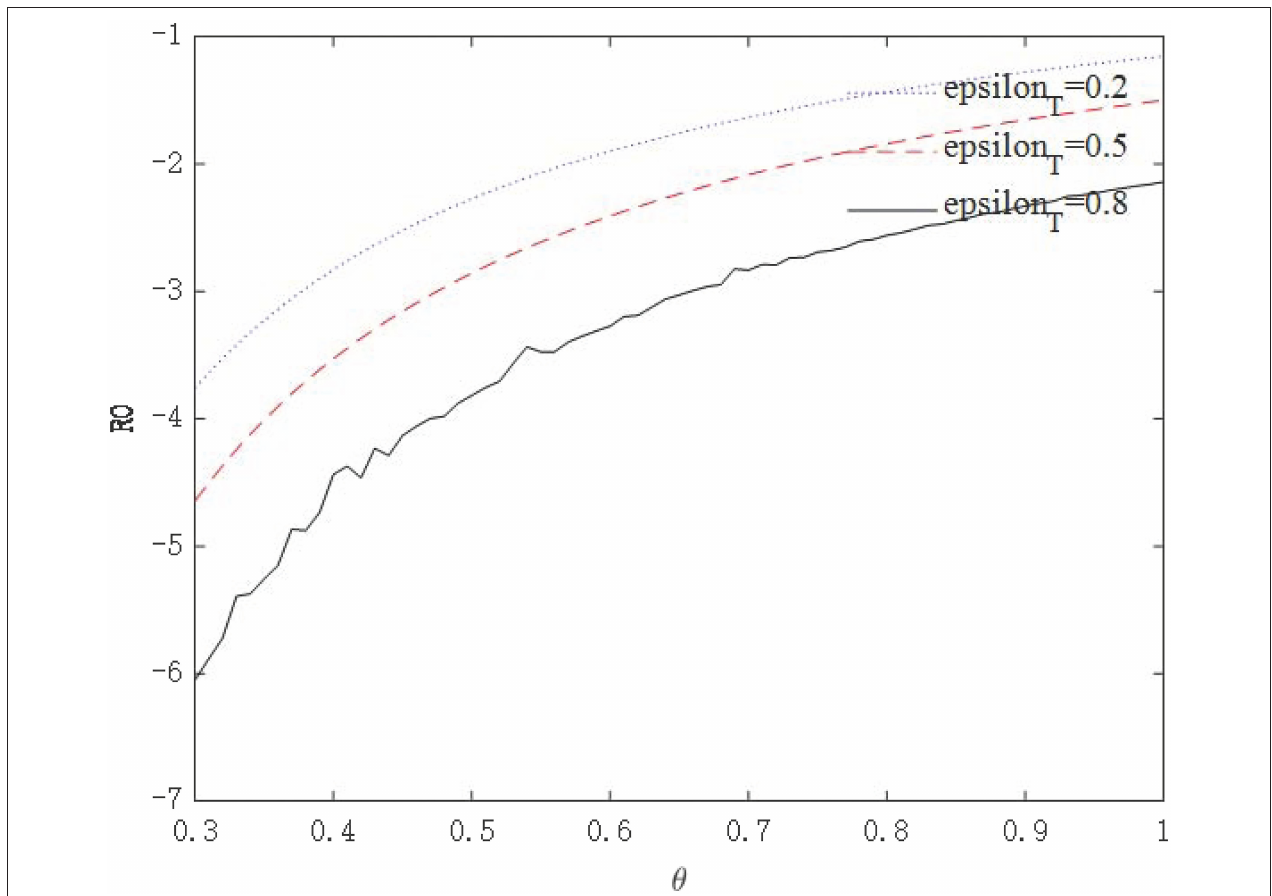
FIGURE 11 | The relationship between R 0 and θ under tracing